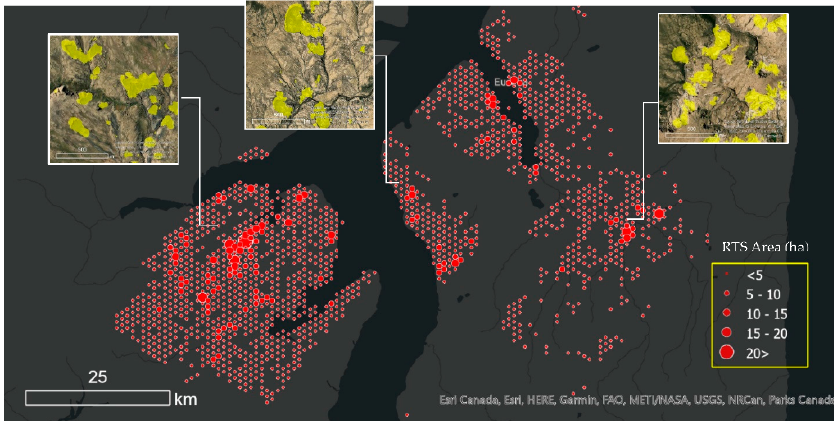
Figure 25. Retrogressive thaw slump (RTS) map for the Eureka Sound Lowlands based on the predictions of the optimal DLCNN model that was trained based on combined hand-annotated samples and optimal image tile size and network input size. The size of the map symbol (red circle) is proportional to the area (in ha) of the RTS falling inside a hexagonal grid. Each grid cell covers 100 ha. Yellow shading on zoomed-in views indicates detected RTS.